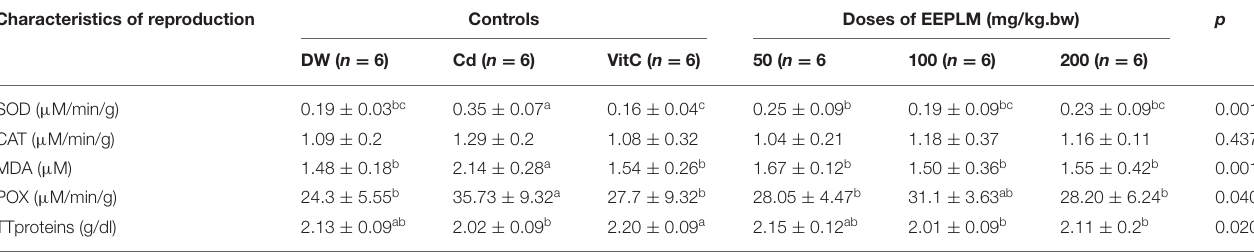
TABLE 5 | Effects of EEPLM on oxidative stress biomarkers in male guinea pigs exposed to cadmium chloride. Characteristics of reproduction Controls Doses of EEPLM